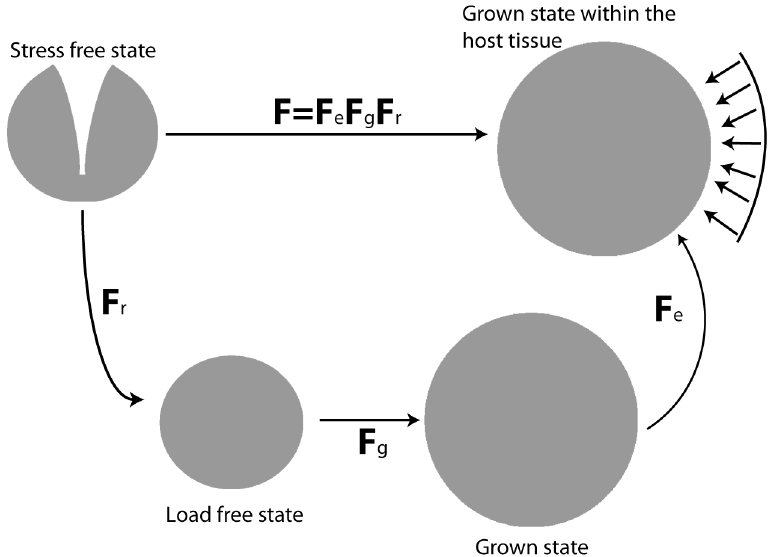
Figure 1. Multiplicative decomposition of the deformation gradient tensor. The stress free state corresponds to an excised tumor having the growth-induced (residual) component of the solid stress released [2,3]. The load free state corresponds to an excised tumor currying no external loads but holds residual stress, described by F r . The grown state corresponds to the volumetric growth of the tumor, which is described by F g and the grown state within the host tissue corresponds to the final configuration of the grown tumor accounting for external stresses (arrows) by the host tissue and described by F e .